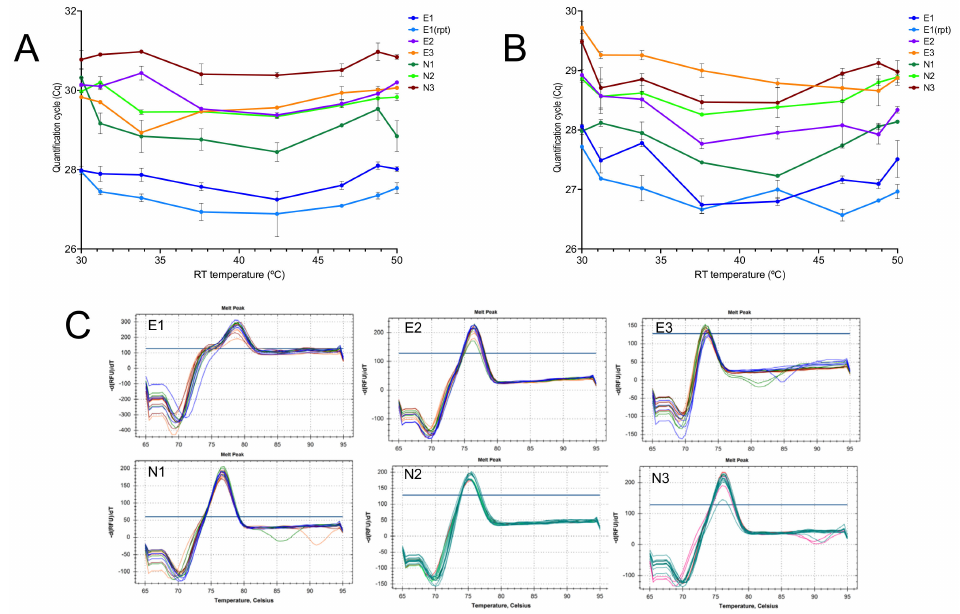
Figure 2. Amplification with assays E1, E2, E3 and N1, N2 and N3 of RNA reverse transcribed by SS4 on an RT gradient. ( A ) Plot of Cqs vs. RT temperature gradient, with PCR amplicons detected by hydrolysis probes. ( B ) Plot of repeat reaction detected using SYBR Green. ( C ) Melt curves for the six